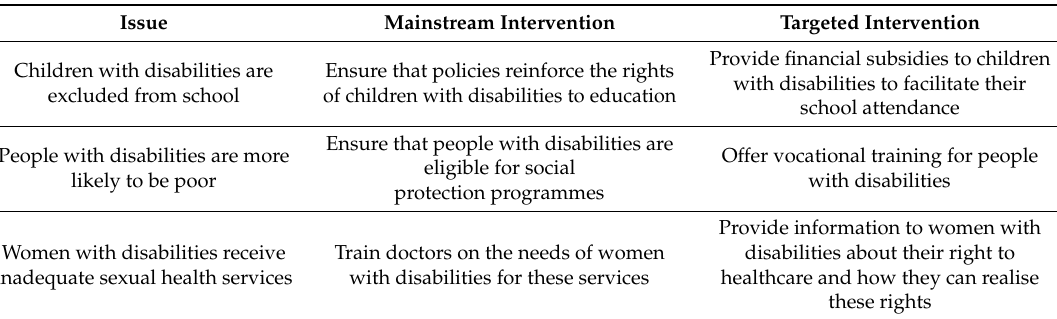
Table 2. Examples of the twin-track